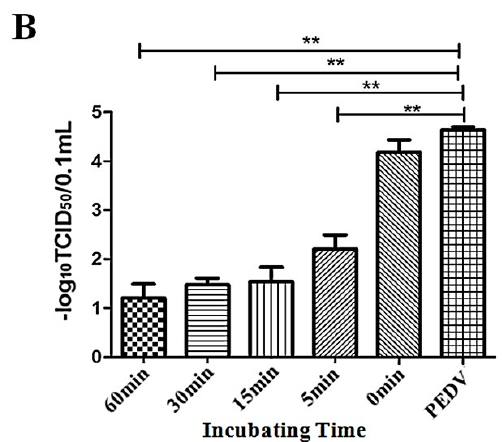
Figure 2. The most suitable incubating conditions of porcine epidemic diarrhea virus (PEDV) and Caerin1.1. The titer of PEDV was detected under different conditions. ( A ) Incubating PEDV with Caerin1.1 (10 μ g/mL) at different temperatures (37, 25, 4 °C) for one-hour pre-infection; ( B ) Incubating PEDV with Caerin1.1 (10 μ g/mL) at different time points (60, 30, 15, 5, 0 min) at 37 °C pre-infection. The control groups (PEDV) of A and B were treated without any Caerin1.1 at 37 °C. The results are presented as the mean ± SD of three independent experiments. The statistical analysis was performed using Graph Pad Prism5.0. Significance was defined as p < 0.05 (*), and higher significance was defined as p < 0.01(**).